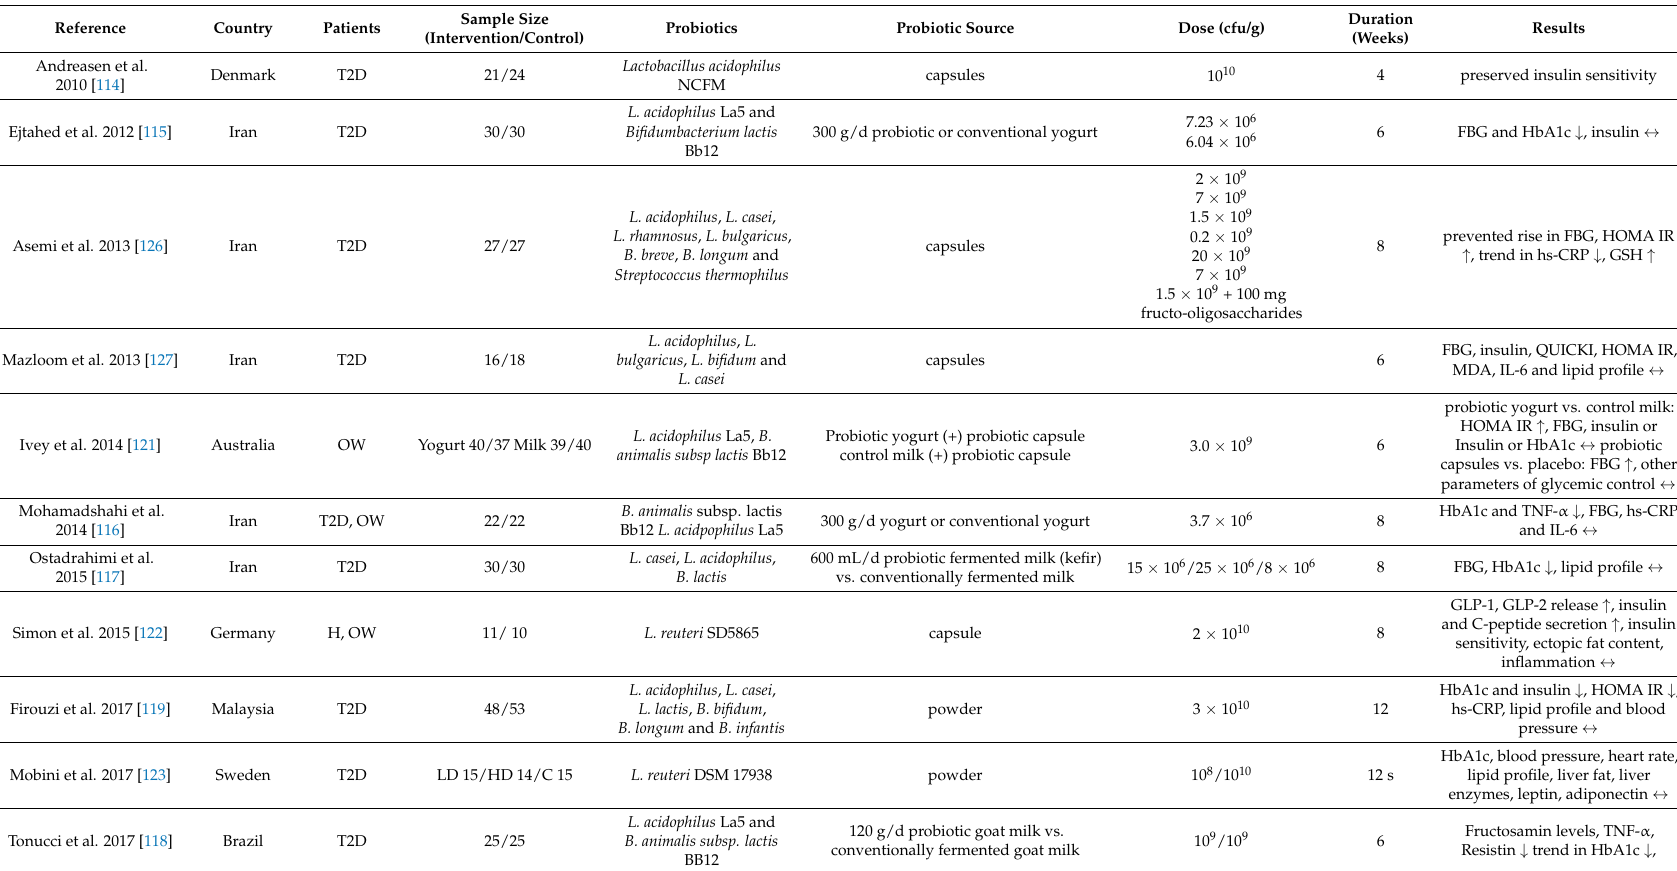
Table 1. Characteristics of randomized clinical